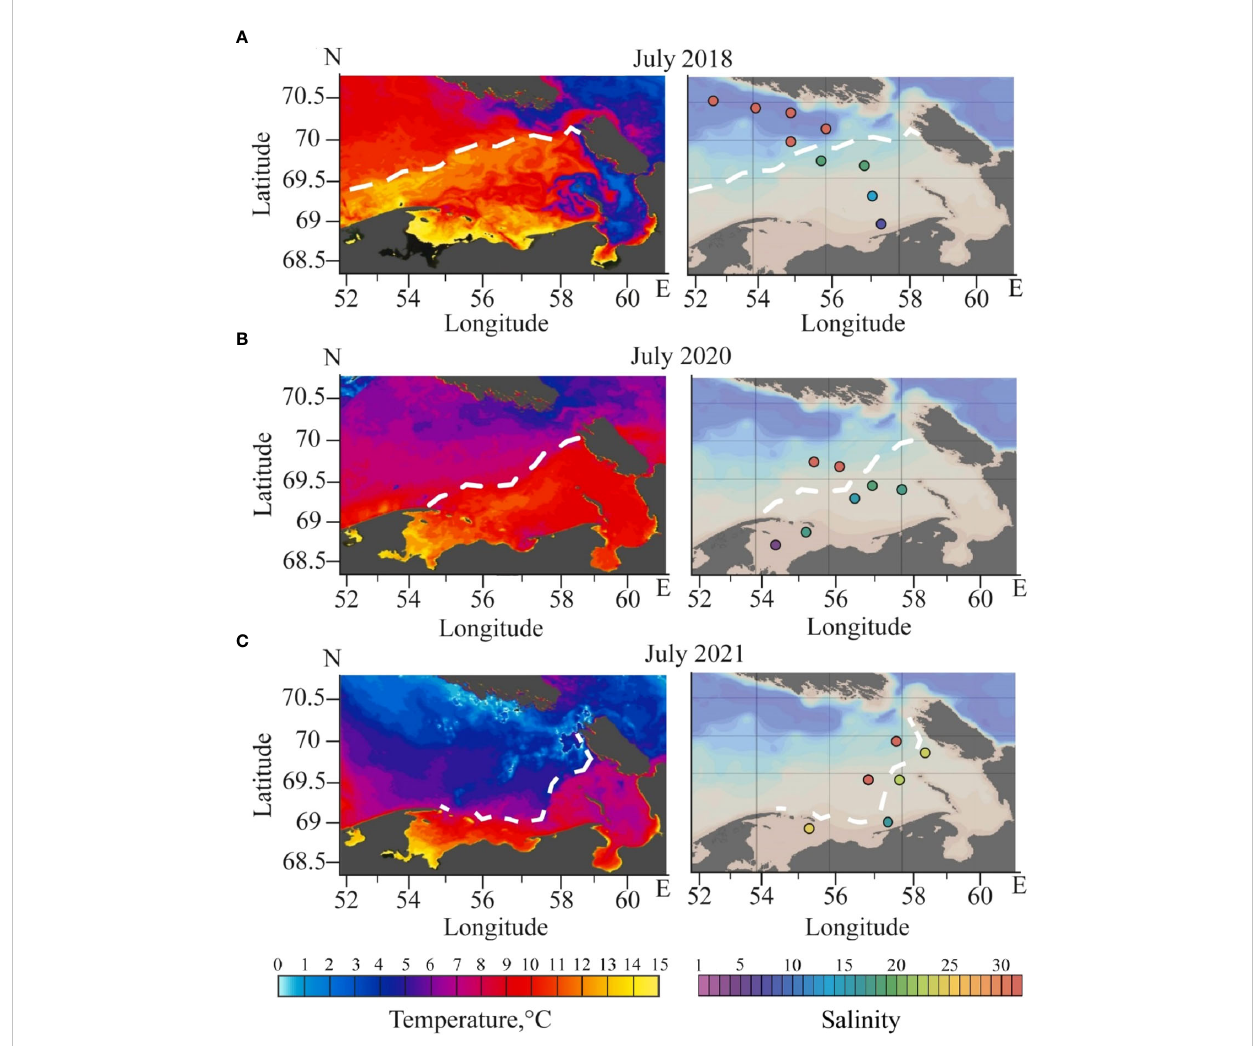
FIGURE 4 Locations of the Pechora plume border (white dashed lines) detected by satellite thermal imagery (left) and in situ salinity data (right) on 21 July 2018 (A) , 19 July 2020 (B) , and 7 July 2021 (C) . Surface salinity values acquired from in situ measurements are shown by color